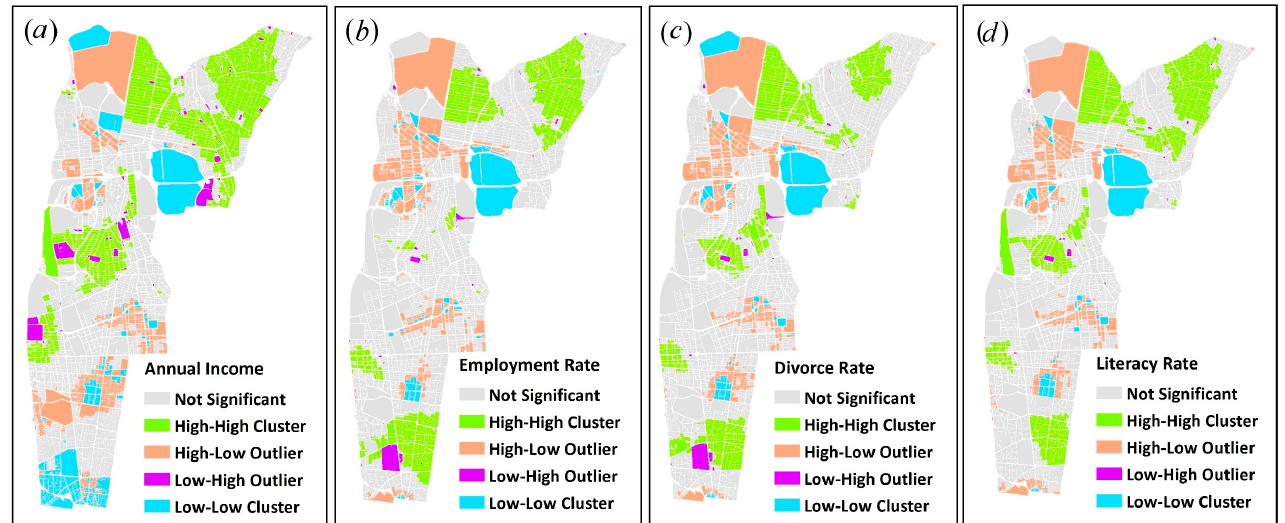
Figure 12. An example of the GetSpatialClusters operation output applied to geodemographic data of Tehran: ( a ) annual income, ( b ) employment rate, ( c ) divorce rate, and ( d ) literacy rate.